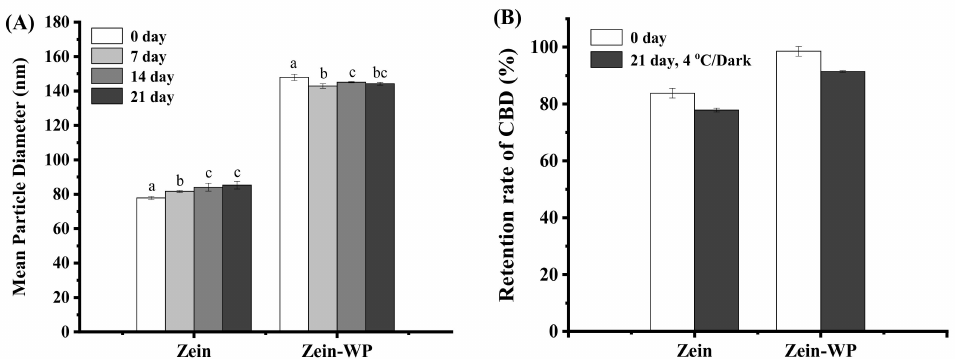
Figure 7. Influence of storage period on mean the particle diameter ( A ) and retention rate of CBD ( B ) of the composite nanoparticles. Note: different lowercase letters indicate the significant difference ( p < 0.05) between samples s at different biopolymer ratios.